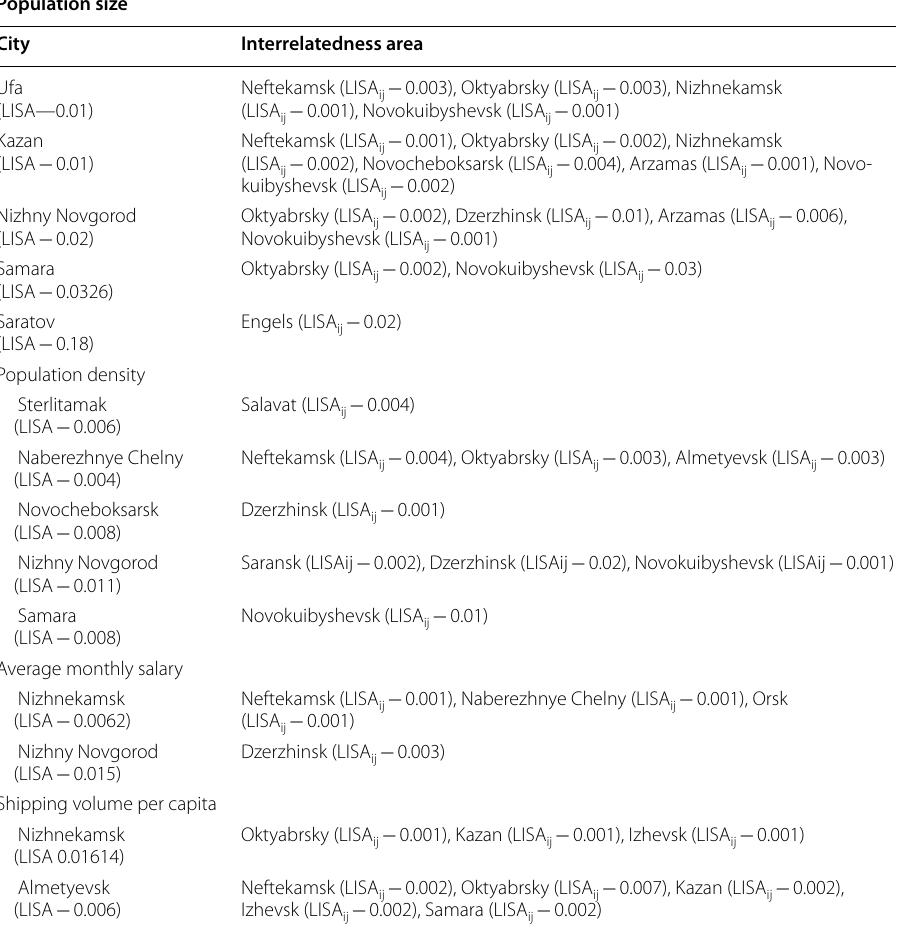
Table 6 Leading cities by the results of the Moran’s index calculation on the Volga Federal District of Russia in